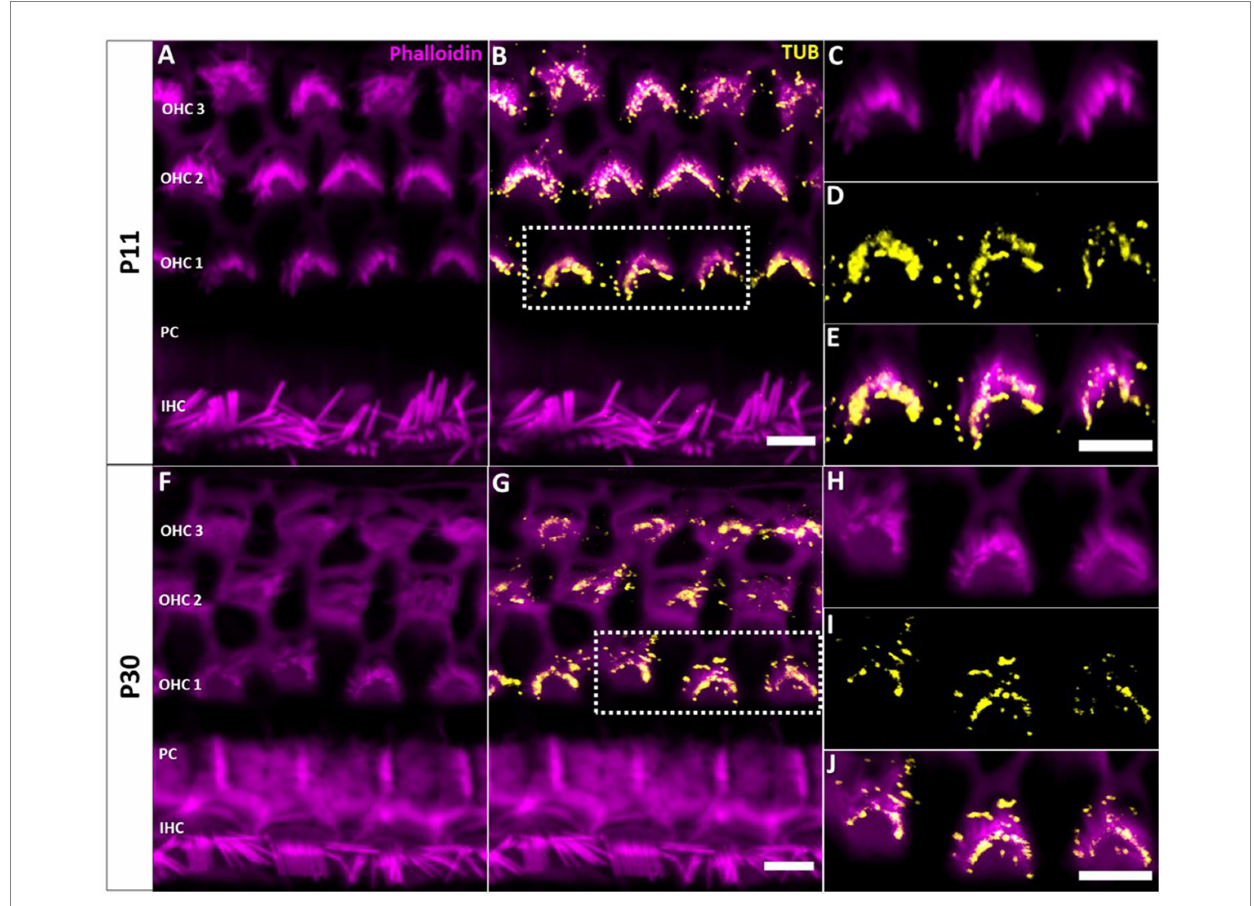
FIGURE 1 Localization of tubby immunoreactivity in the tips of OHC stereocilia. Whole mount immunohistochemical staining of Tubby (yellow) with Phalloidin (staining actin, magenta) in the mouse organ of corti. (A,B) P11, (F,G) P30. Strong immunoreactivity of tubby is present in the distal and basal parts of OHC stereocilia, corresponding to the horizontal tip connectors (HTC) and tectorial membrane attachment-crowns (TM-AC). (C−E,H−J) Close-up of identical staining at P11, i.e., P30. Scale bar 5 μ